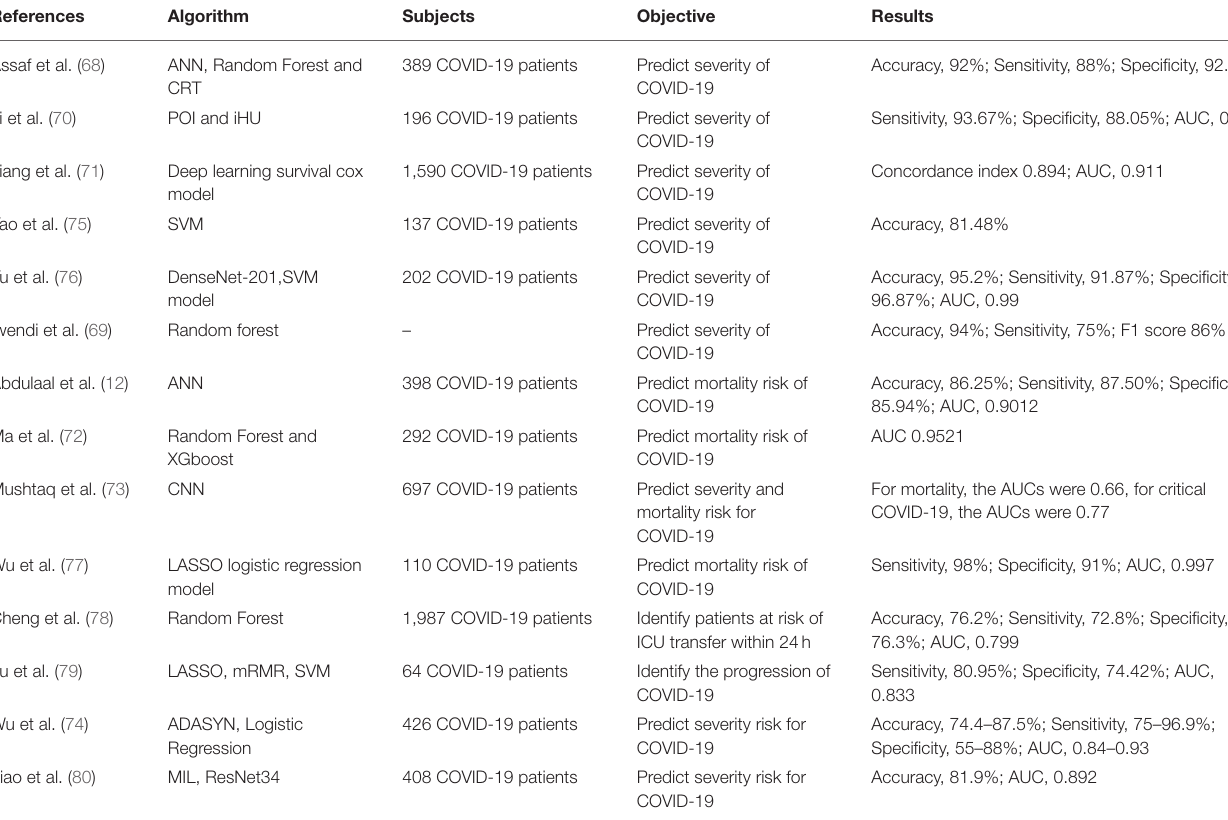
TABLE 4 | Application of AI in predicting prognosis of